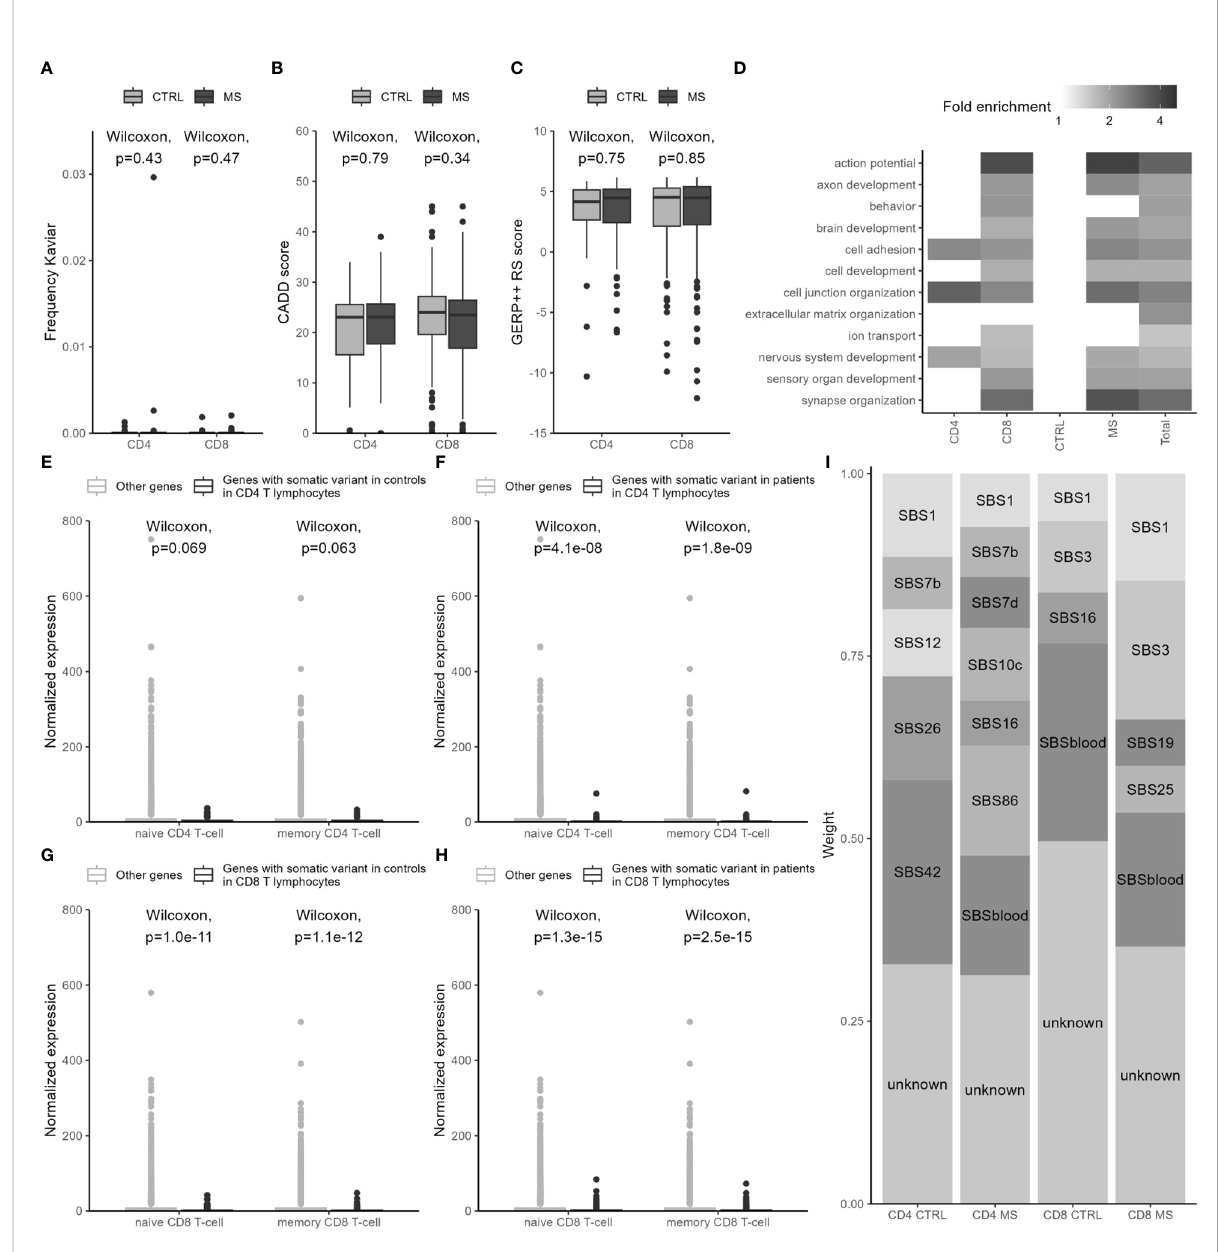
FIGURE 3 Somatic variants have characteristics compatible with a damaging effect but are located in lowly expressed genes not speci fi c for the affected cell subsets. (A) Frequency of somatic variants in Kaviar, a database for germline variants. (B) CADD scores of somatic variants as an estimate of predicted deleteriousness. (C) GERP++ score as a measure of conservation of sites at which somatic variants are located. (D) Fold enrichment of a subset of GO terms related to biological processes in different sets of somatic variants. As fewer controls were included, the power of this analysis was insuf fi cient to obtain results with a false discovery rate (FDR) ≤ 5%. Fold enrichment is only included for over- and underrepresentations with an FDR ≤ 5%. An overview of all GO terms with FDR ≤ 5% is given in Supplementary Figure 3. (E – H) Normalized gene expression in the relevant CD4 + and CD8 + T-cell subsets for genes affected by somatic variants in CD4 + in controls (E) , in CD4 + in MS patients (F) , in CD8 + in controls (G) , and in CD8 + in MS patients (H) and other genes screened for somatic variants. (I) Mutational signatures, consisting of prede fi ned combinations of single base substitutions (SBS), found in sets of somatic